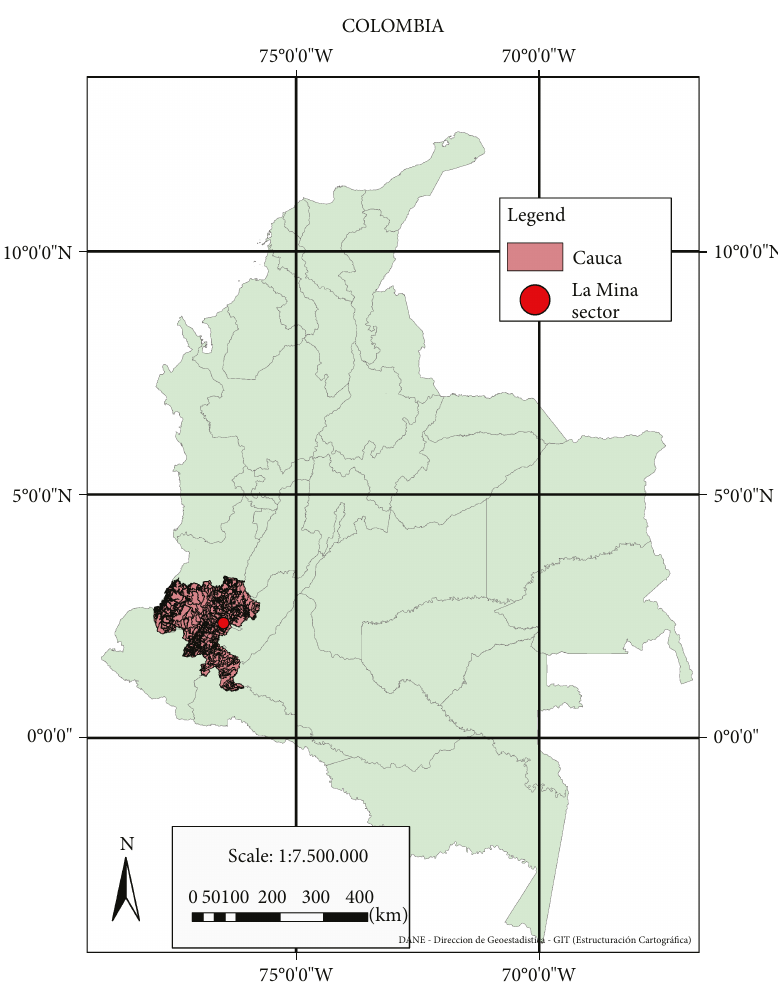
Figure 1: Colombian map and location of La Mina sector. Map of the Agustin Codazzi Geographic Institute